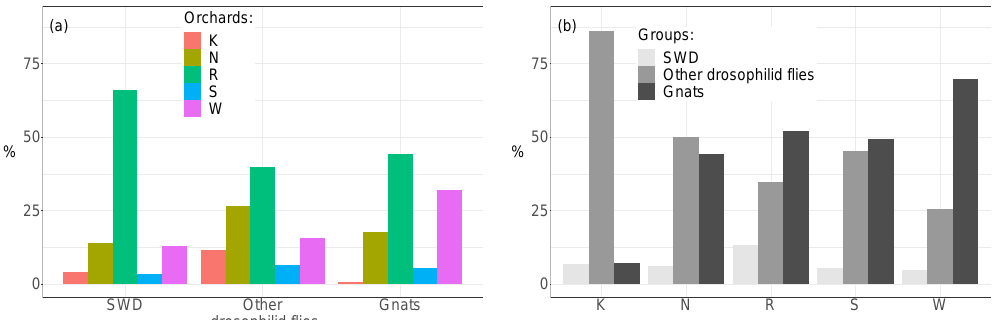
Figure 1. SWD, other drosophilid flies, and gnats between ( a ) and within ( b ) orchards. Parasitic wasps are not shown due to their low number. Abbreviations for orchards: K = Kaisten, N = Notikon, R = Rotkreuz, S = Schupfart, W = Wölflinswil.